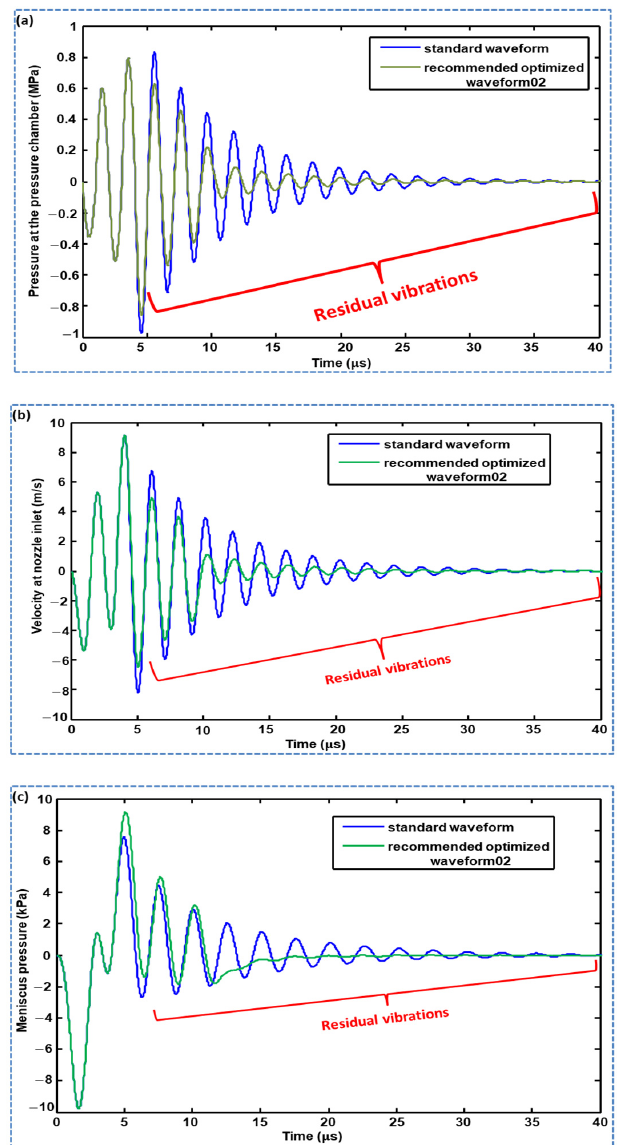
Figure 13. Comparison of profiles of: ( a ) pressure at the pressure chamber; ( b ) velocity at nozzle inlet; and ( c ) meniscus pressure generated by the standard waveform and recommended optimized Waveform 02.